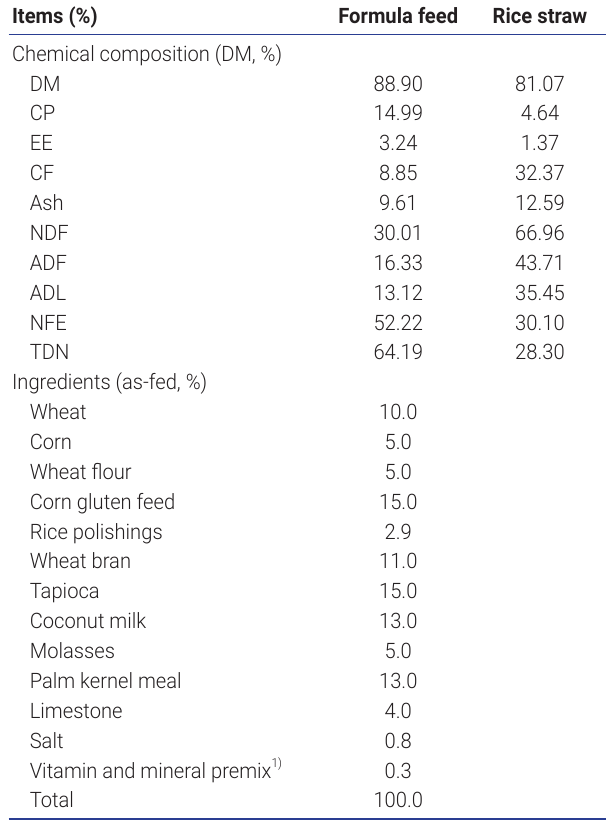
Table 1. Chemical composition of formula feed and rice straw, and ingredients of the formula